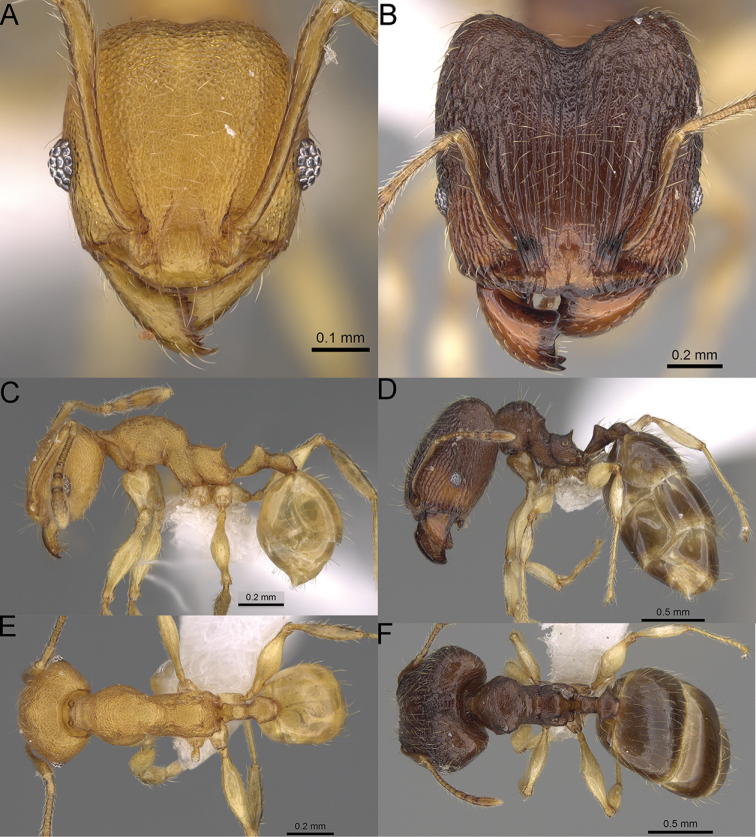
Pheidole
bemarahaensis sp. nov., full-face view (A), profile (C), and dorsal view (E) of paratype minor worker (CASENT0425239) and full-face view (B), profile (D), and dorsal view (F) of holotype major worker (CASENT0425236).